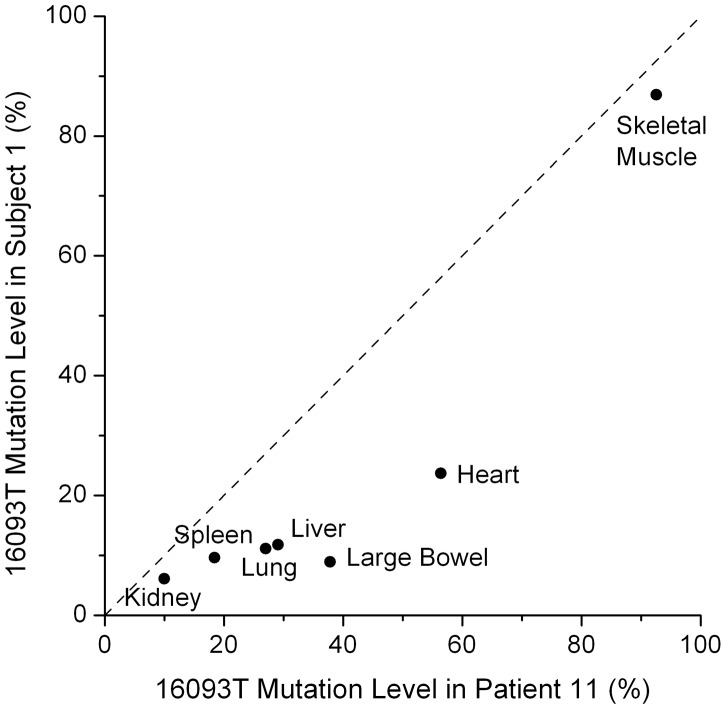
Tissue dependent heteroplasmy levels of the 16093 T/C variant across two subjects.The heteroplasmy levels in these two subjects have a correlation of 0.93 (p = 0.003). The diagonal line shows equal values in the two subjects. Patient 11 is from He et al.
[9].